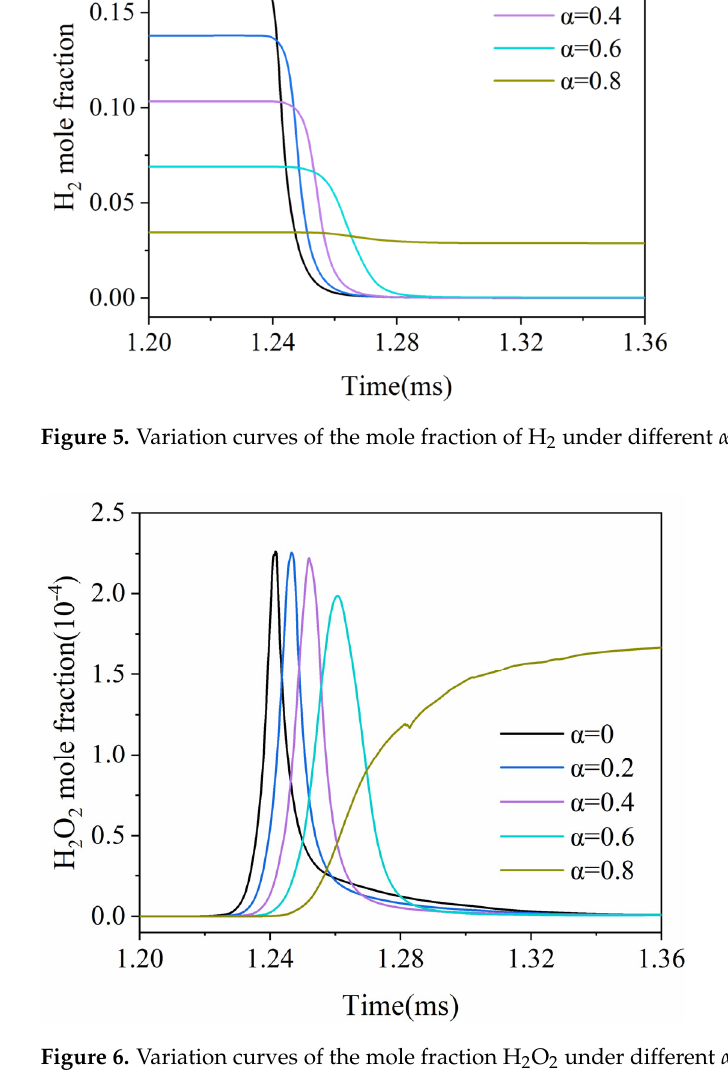
2 O 2 under different α